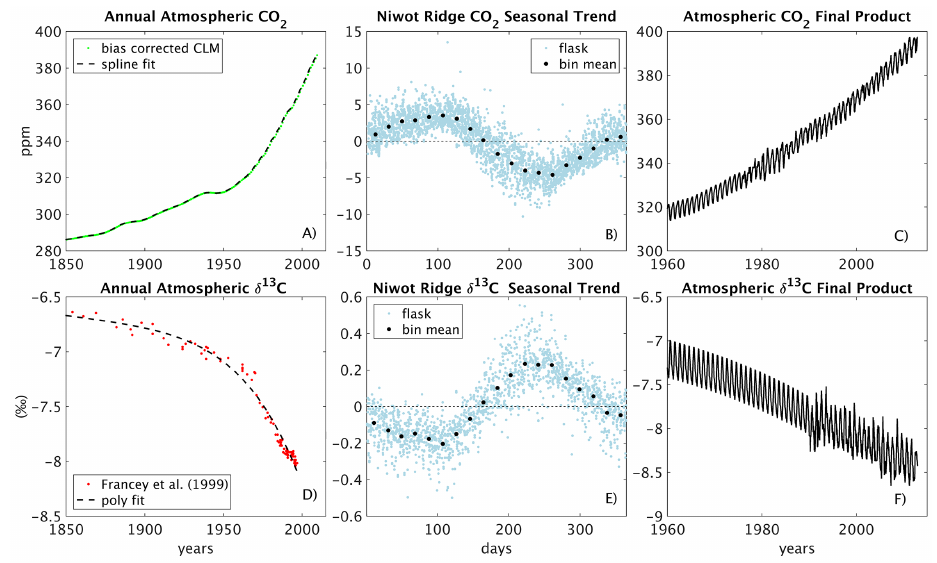
Figure 2. Niwot Ridge synthetic data product for atmospheric CO 2 concentration ( c a ) (a, b, c) and δ 13 C of CO 2 (δ atm ) (d, e, f) . The final time series (c, f) were used as a boundary condition for CLM, and created by combining the annual trends reported by Francey et al. (1999) adjusted for Niwot Ridge (a, d) with the mean seasonal cycles measured at Niwot Ridge (b, e) . Table 2. CLM4.5 model formulation description based upon timing of nitrogen limitation. Pre-photosynthetic and post-photosynthetic nitro- gen limitation are achieved through V cmax25 calibration (Eq. 17) and f dreg (Eq. 8), respectively. /c a A n − g s Formulation Pre-photosynthetic Post-photosynthetic Impacts c ∗ i nitrogen